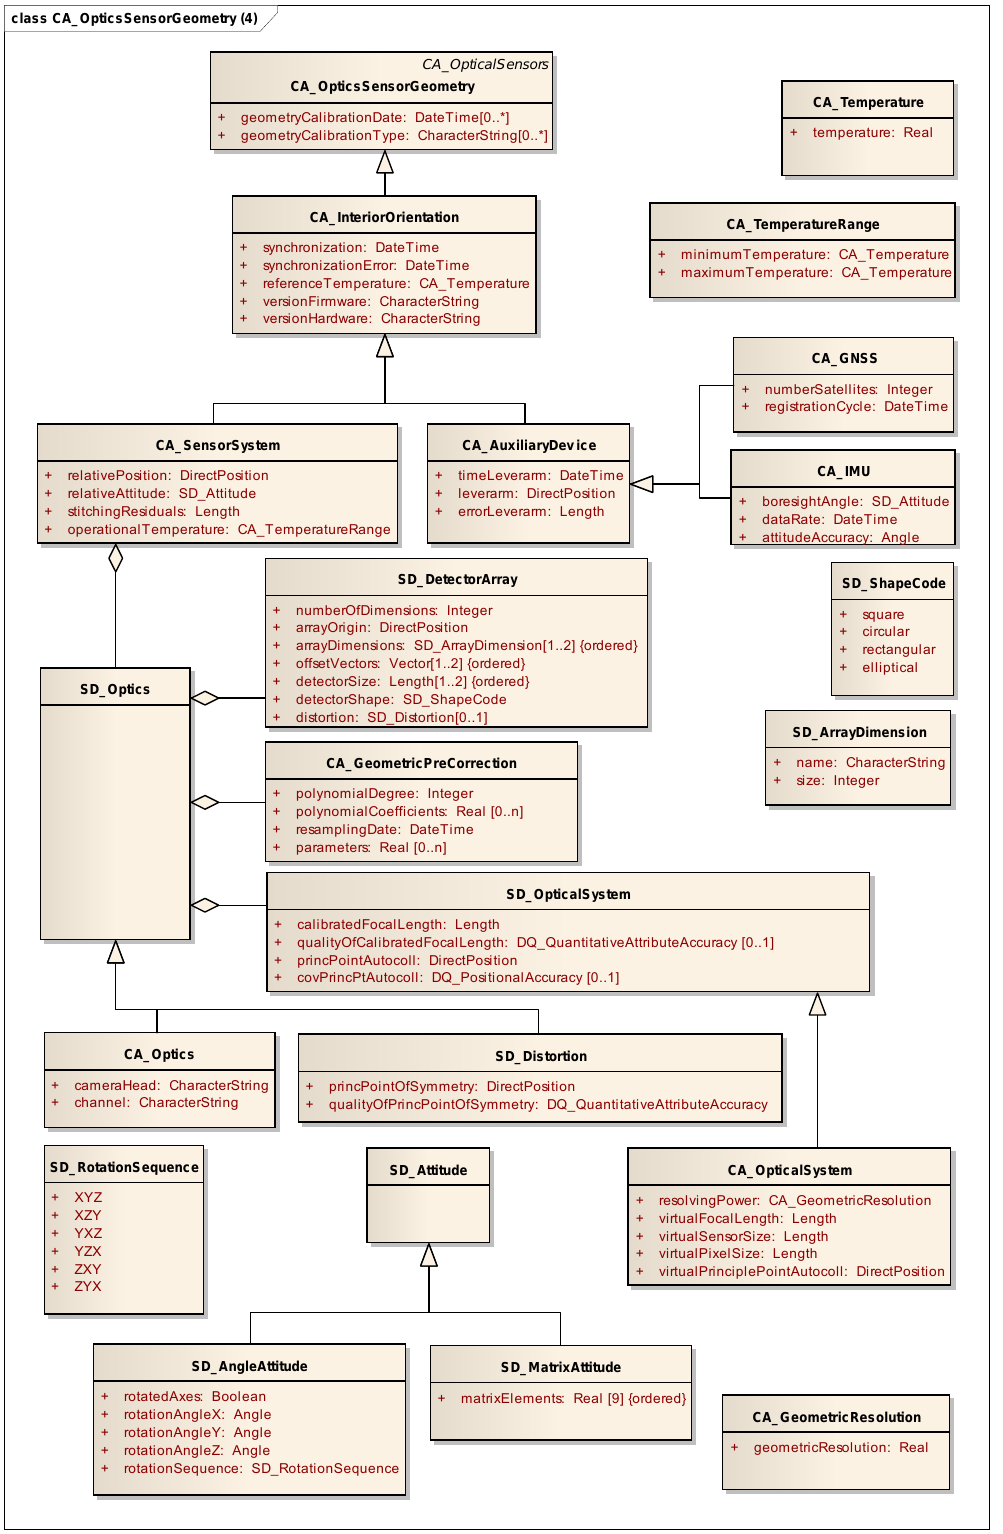
Figure 2. Geometry classes for the calibration of optical sensors, SD = classes of the ISO/TS-19130-model (ISO/TS 19130 2010), CA = classes of the ISO/TS-19159-1-model (ISO/TS 19159-1